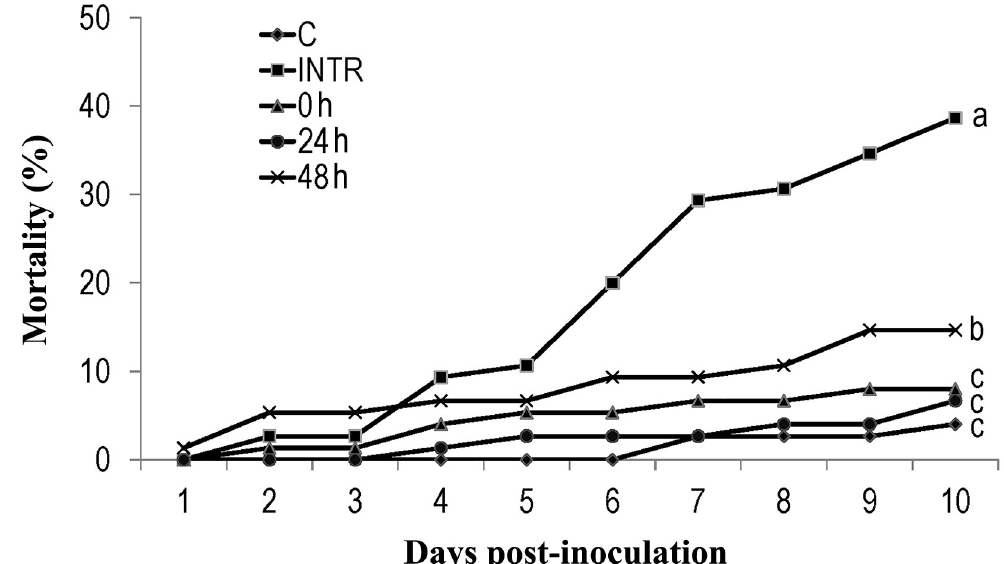
Fig 5. Effect of thermoregulation onset on mortality of infected locusts. Mortality of Locusta migratoria manilensis inoculated with Beauveria bassiana (10 6 spores/5 th instar nymph) and exposed to various thermoregulation durations (0 h, 24 h and 48 h post-inoculation are indicated by filled squares, triangles, circles and Xs, respectively). The 0 h regime corresponds to infected locusts allowed to thermoregulate immediately after infection. INTR indicates inoculated and non- thermoregulating locusts. C indicates non-thermoregulating and non-infected control locusts. n = 25 insects per treatment. ANOVA on mortality at day 10 is followed by LSD (different letters indicate significant differences).